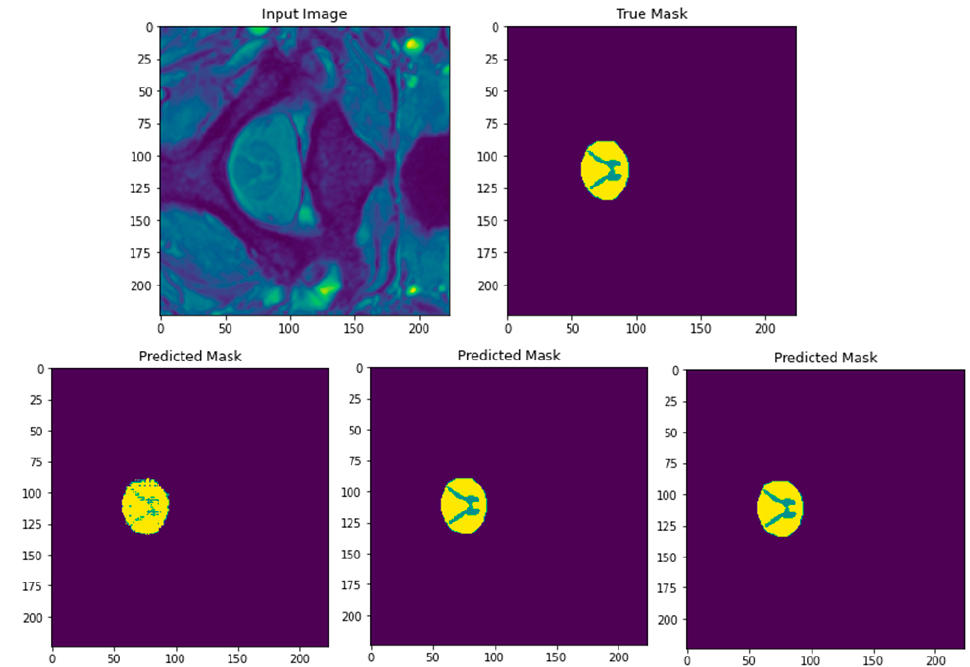
Figure 14. Original input test image of SCGM and its corresponding ground truth mask (top row). Predicted masks after segmentation with the three used optimizers (bottom row from left to right: SGD, Adam, and RMSProp). A batch size of 8 and 400 epochs are applied. Table 5. Obtained values of five segmentation metrics using the three optimizers: SGD, Adam, and RMSProp. For each optimizer, a batch size of 8 samples and 400 epochs are utilized.